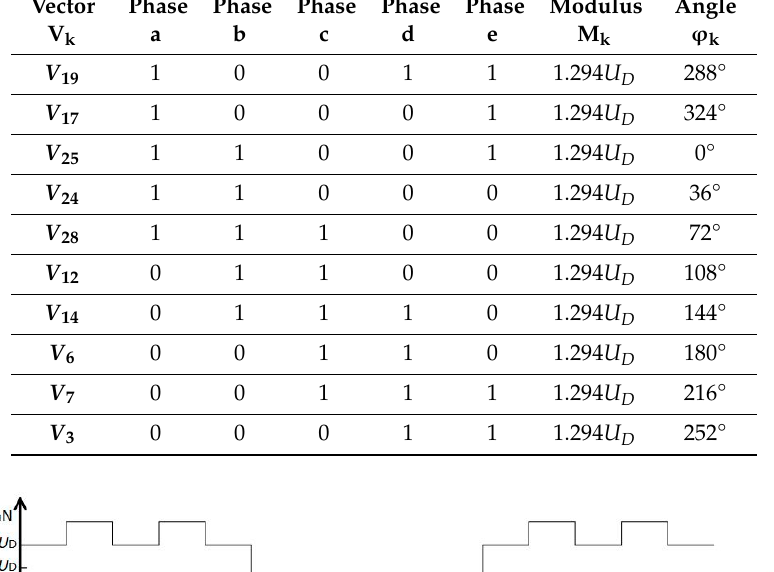
Table 2. Parameters of the vectors. Red color denotes potential + U D , green color – potential 0.